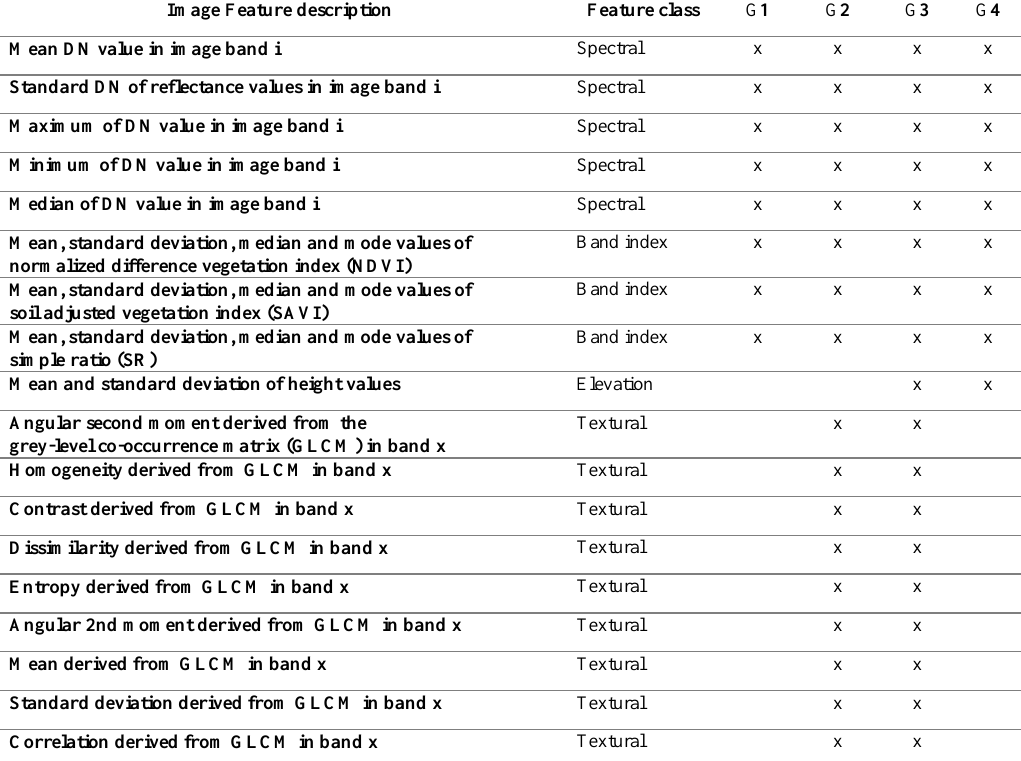
Table 2. The main feature class and its associated image